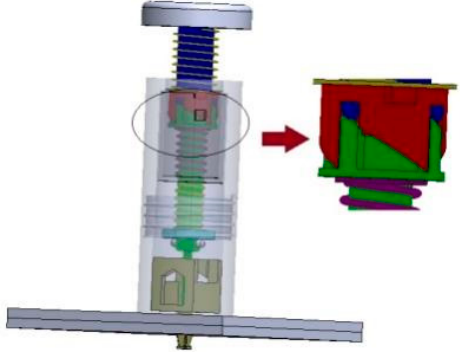
Figure 8. Schematic diagram of step 6.